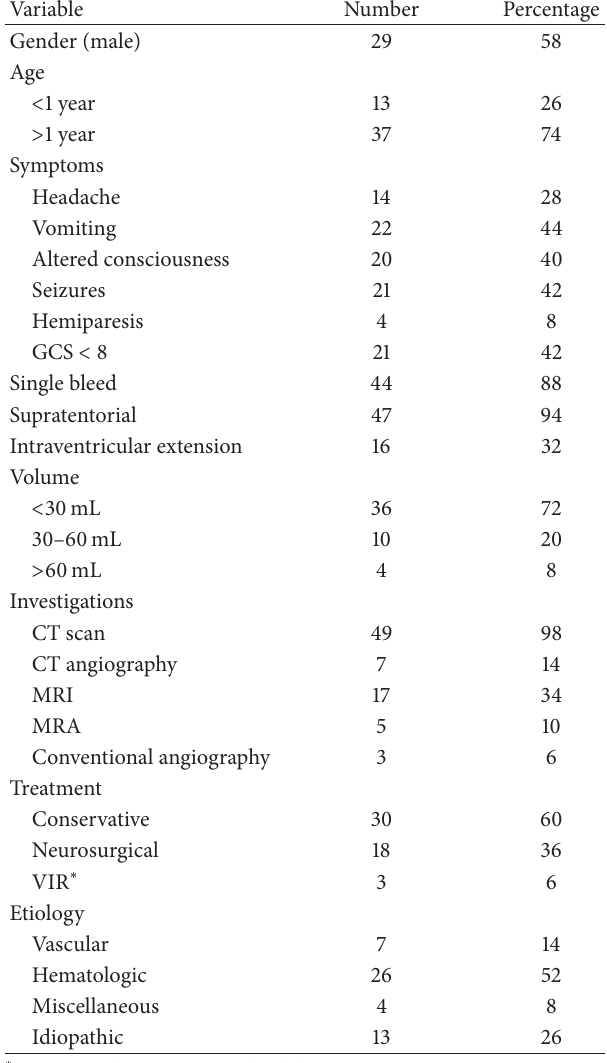
Table 1: Basic demographic and clinical data ( 𝑛 = 50